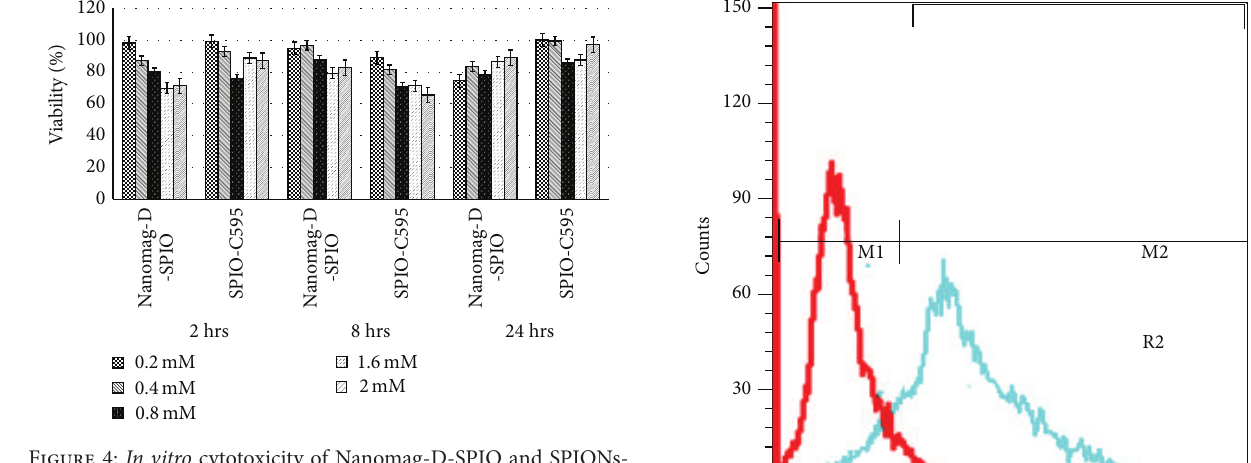
Figure 4: In vitro cytotoxicity of Nanomag-D-SPIO and SPIONs- C595 in OVCAR3 cell line by the MTT assay with different Fe concentrations ranging from 0.2 to 2.4 mM for 2, 8, and 24 h.